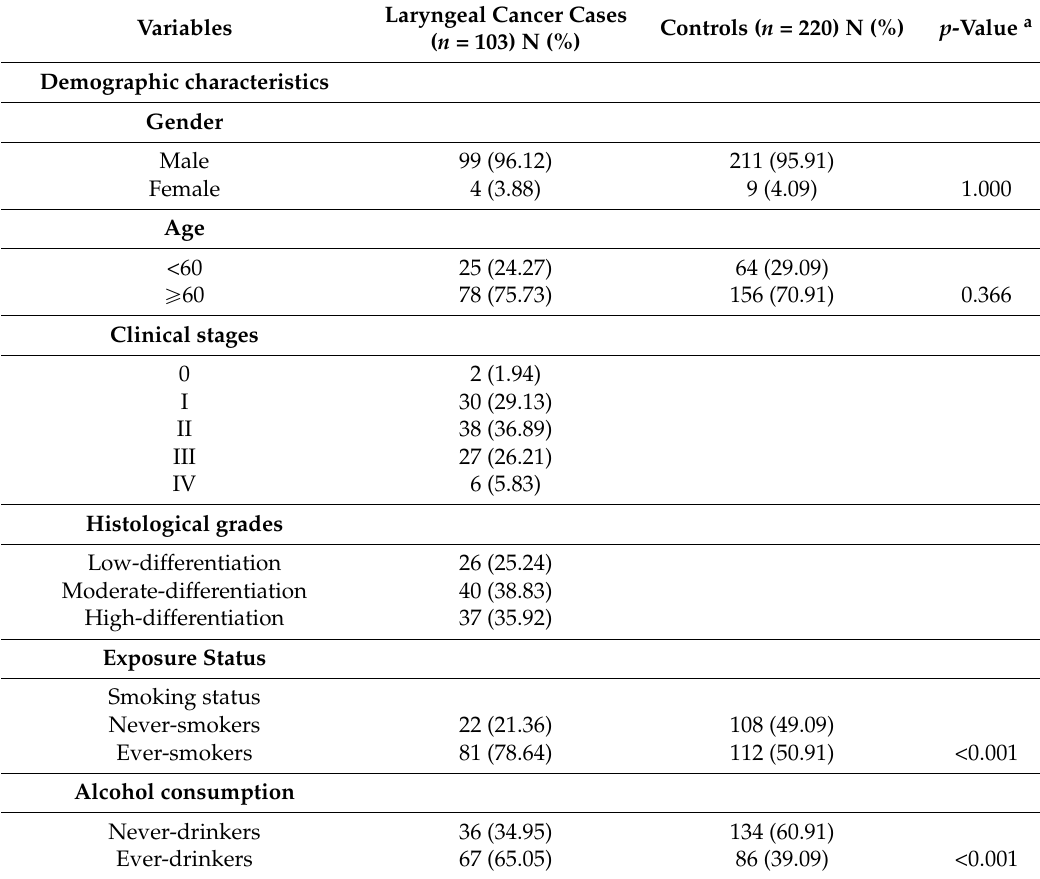
Table 1. The characteristics of